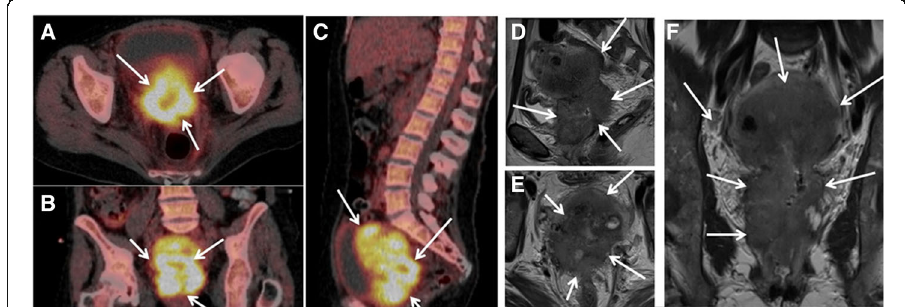
Fig. 1 A 51-year- old woman with FIGO stage IVA cervical cancer with highly FDG avid cervical tumour encircled (arrows in a , b and c ) yielding a MTV of 313, TLG of 2416 and SUVmax of 16. The T2-weighted MR images show a cervical mass (arrows in d , e and f ) extending into the bladder and with parametrial growth causing bilateral hydronephrosis. This patient died from disease two years and nine months after primary diagnosis. ( a : Axial PET/CT, b : Coronal PET/CT, c : Sagittal PET/CT, d : Sagittal T2-weighted MRI, e : Axial T2-weighted MRI and f : Coronal T2-weighted MRI)